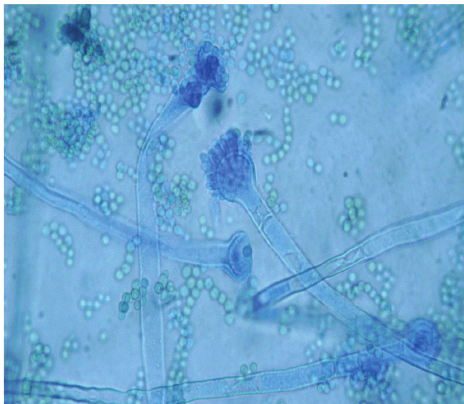
Figure 4: LCB preparation from mixed culture showing ruptured sporangium with developing vesicle in the same field (40x).